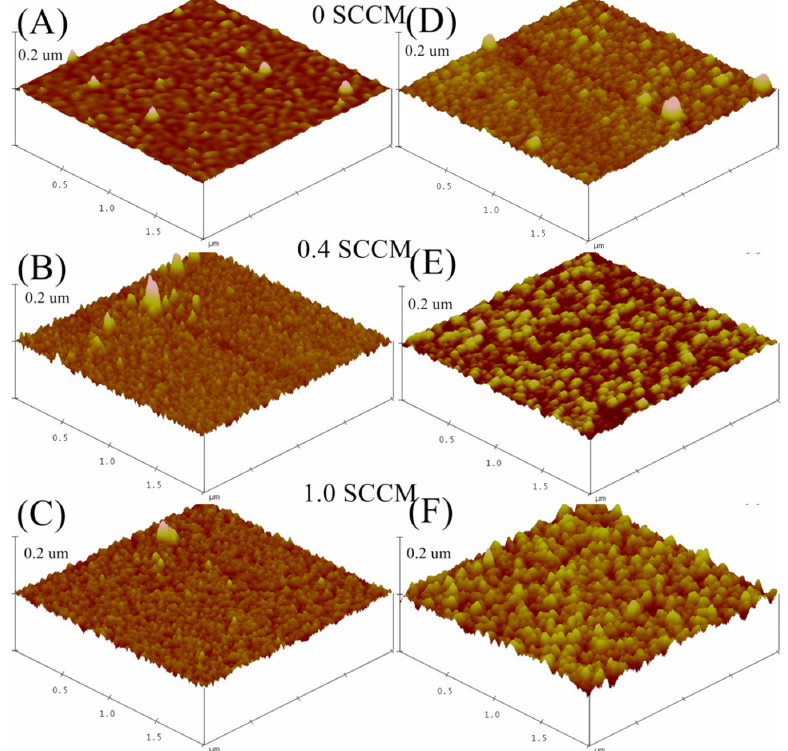
Figure 2. Surface topology image for 2 μ m × 2 μ m × 0.2 μ m of the ITO film deposited under various oxygen environments: ( A ) 0 sccm oxygen, ( B ) 0.4 sccm oxygen, ( C ) 1.0 sccm oxygen, and etched for 8 min, ( D ) 0 sccm oxygen, ( E ) 0.4 sccm oxygen and ( F ) 1 sccm oxygen. ( A – C ) etched for 1 min and ( D – F ) films etched for 8 min. The etching was performed at room temperature.